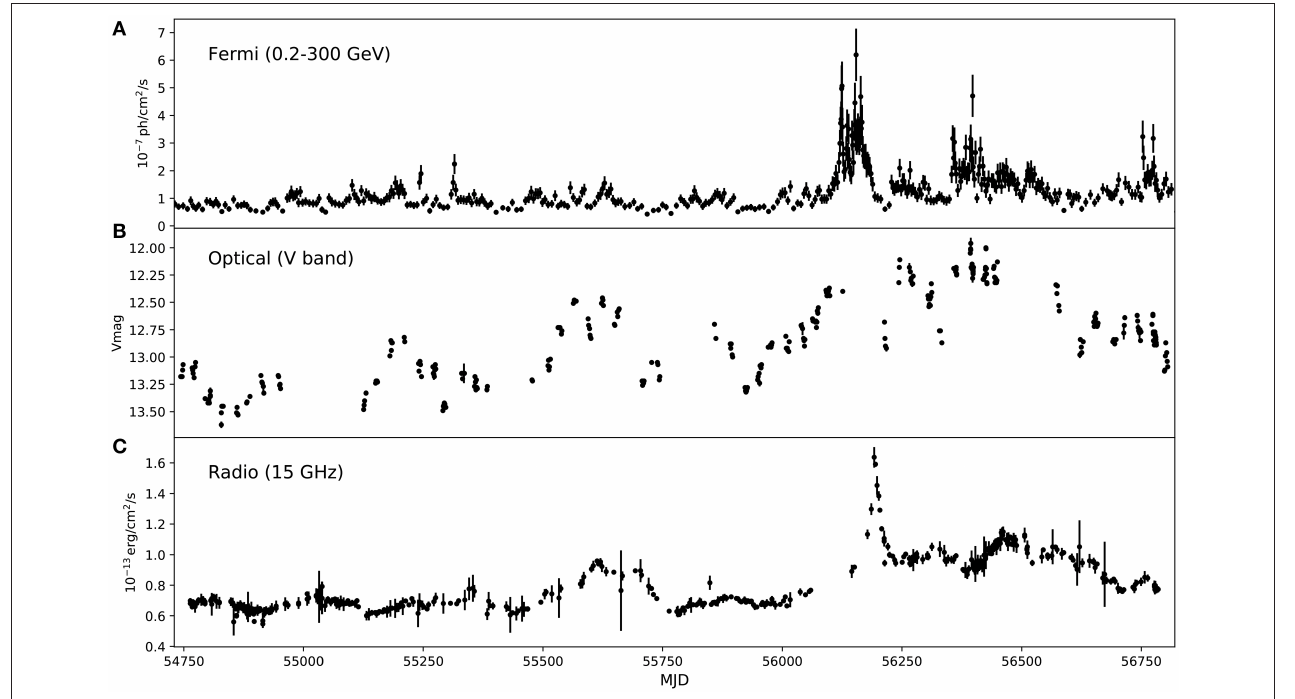
FIGURE 1 | γ -rays, (A) , optical (B) , and radio (C) light curves for Mkn421 from 2008 to